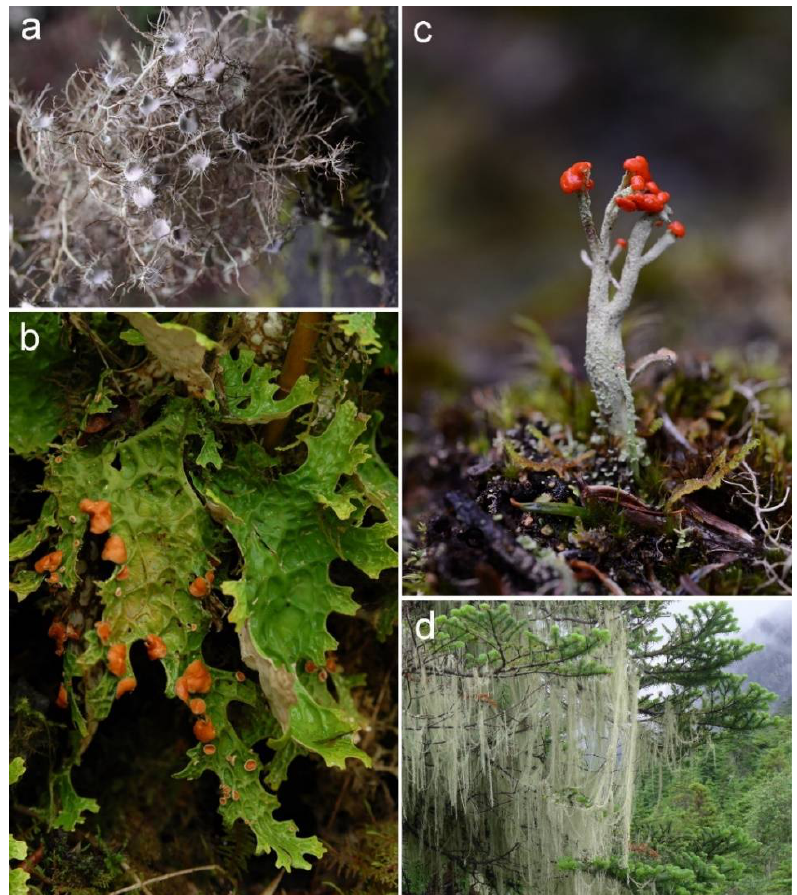
Figure 2. Selected traditional medicinal lichens. ( a ) Sulcaria sulcata (Lév.) Bystrek; ( b ) Cladonia sp.; ( c ) Lobaria sp.; ( d ) Usnea longissima . Photographed by Li-Song Wang.